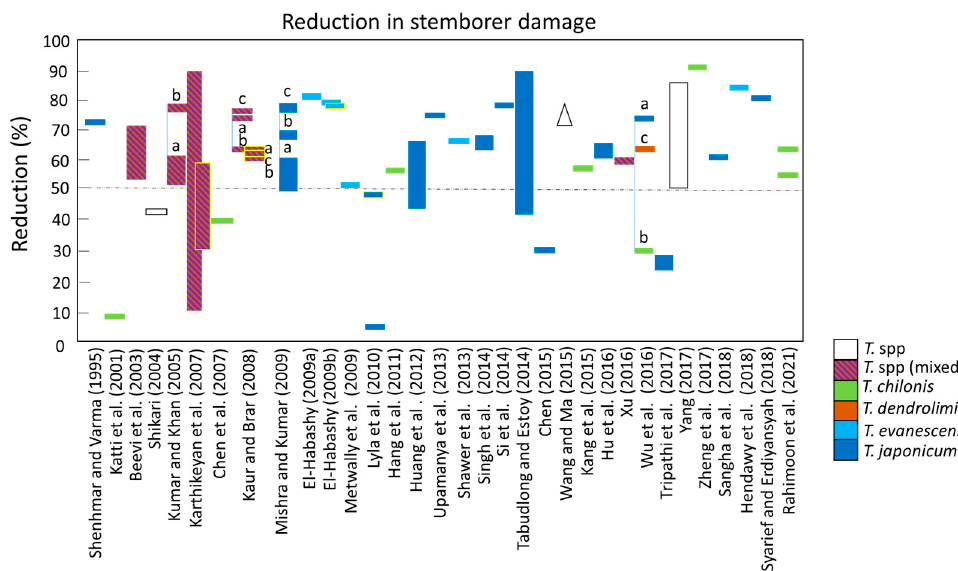
Figure 5. Reductions in rice damage from stemborers due to Trichogramma -based biological control releases as reported for a range of field studies. Bars outlined in yellow indicate reductions in WH damage, otherwise reductions in stem damage or DH are indicated. Bar colors indicate Trichogramma species as shown in the legend. The triangle indicates ‘equal to or greater than’. Note that one study compared Trichogramma species (indicated by lowercase letters associated with different species in the same study) and studies also compared different release densities (indicated by lowercase letters associated with the same species in a single study, i.e., Kumar and Khan (2005) [94], a = 50 K, b = 100 K; Kaur and Brar (2008) [130], a = 100 K, b = 125 K, c = 150 K; Mishra and Kumar (2009) [92], a = 50 K, b = 75 K, c = 100 K) (See Table S1 for further details).